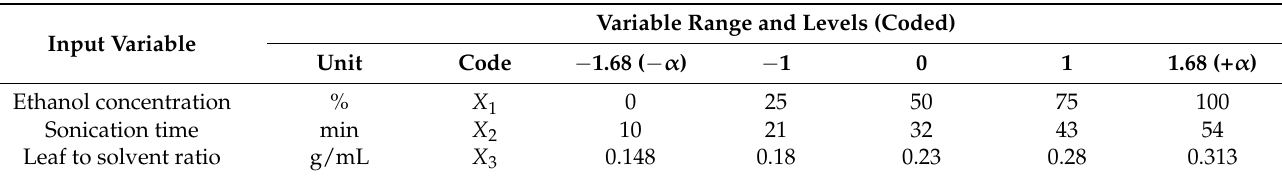
Table 1. UAE process parameters with their particular experimental ranges and